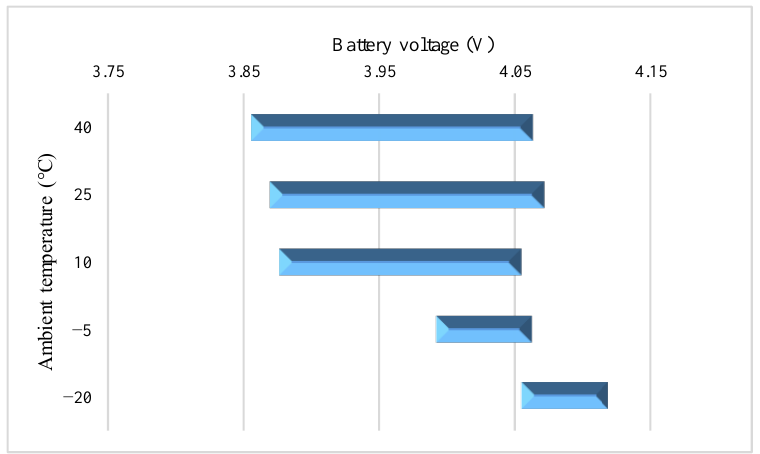
Figure 16. The voltage fluctuation intervals during the VPP with 1.00C charging.